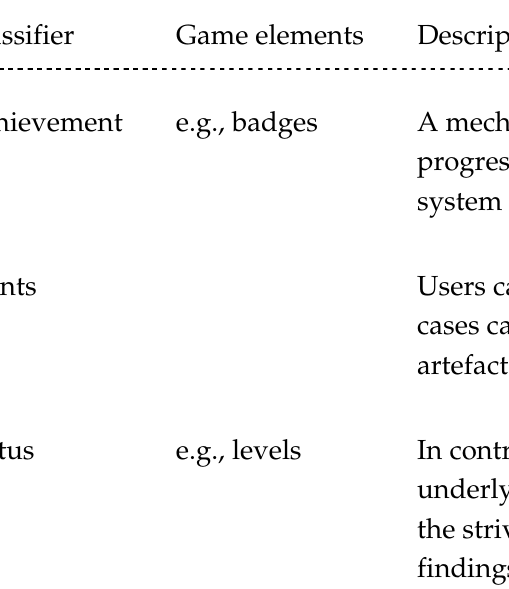
Table 3: Overview of Game Elements Found in the Review of Gamified Participation Tools